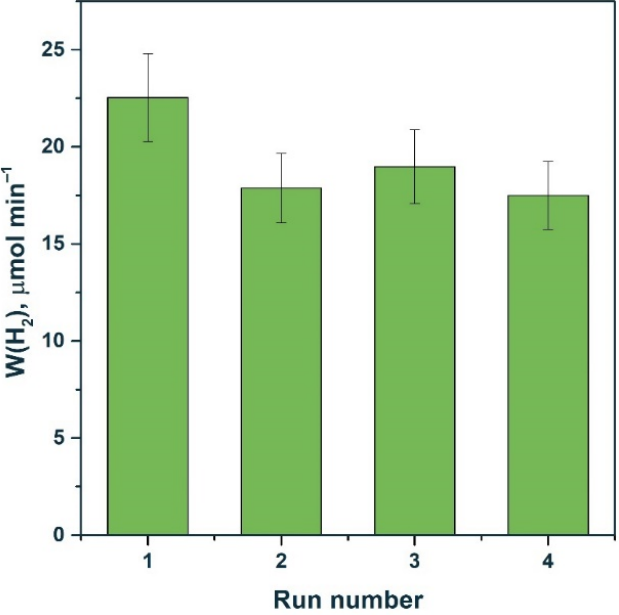
Figure 8. Stability test of 1% NiS/Mn0.6 HT120 photocatalyst. Experimental conditions: Figure 8.